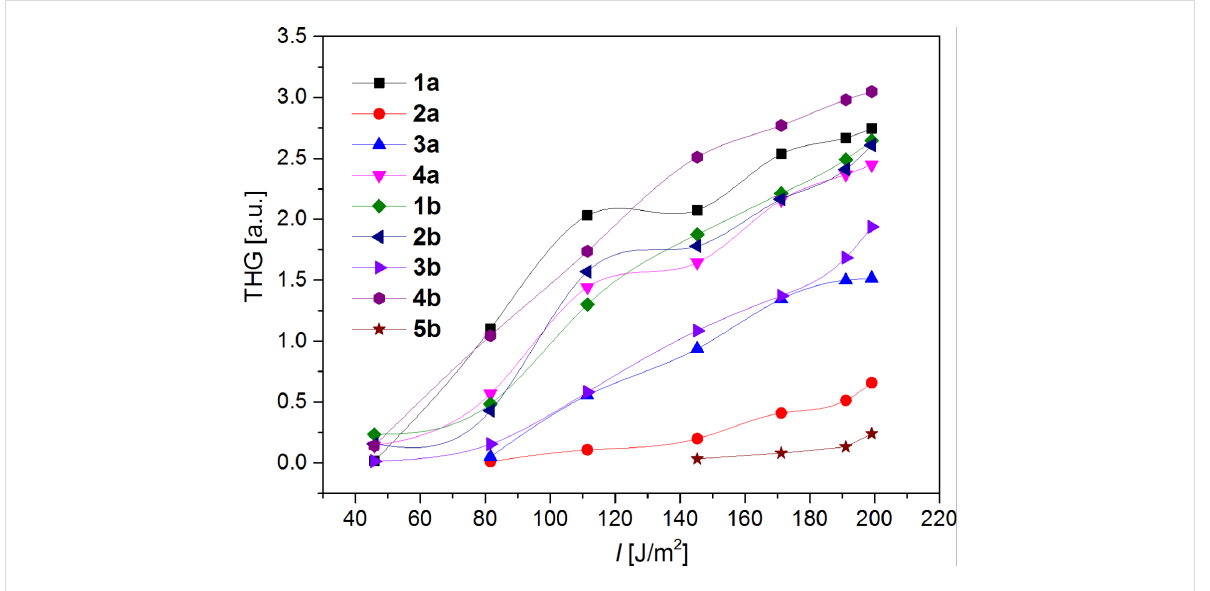
Figure 6: Typical THG dependences vs the fundamental energy density.